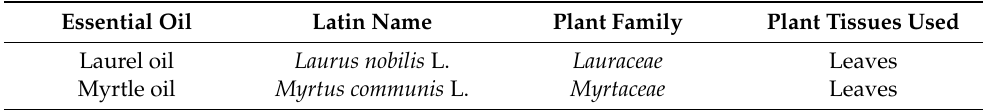
Table 1. List of essential oils (EOs) used in this study. Essential